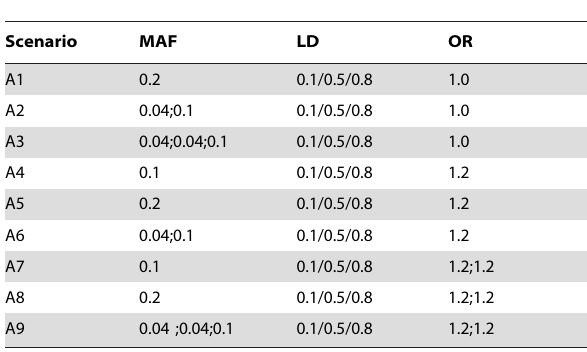
Table 1. Parameter settings of virtual datasets.